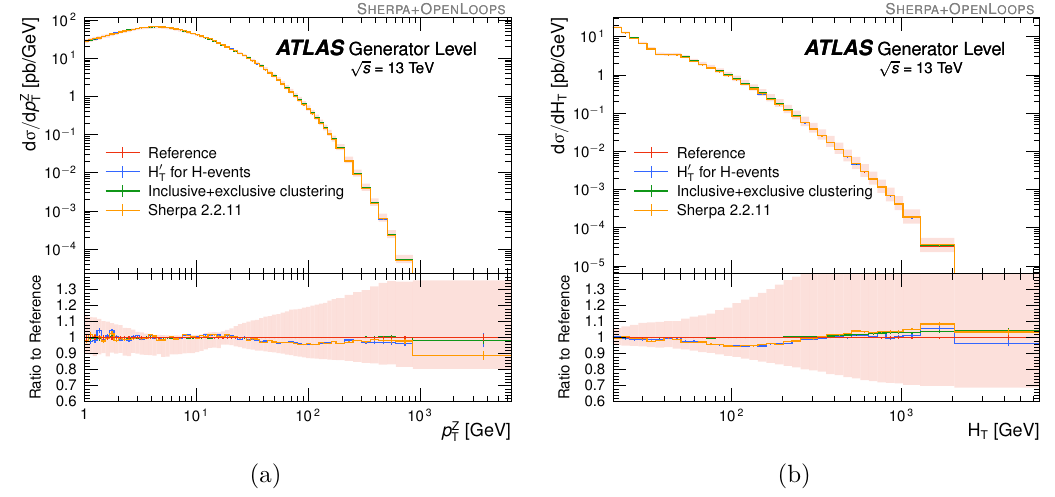
Figure 9 . Differential distributions of (a) the dilepton transverse momentum and (b) scalar sum of the jet momenta for Z → ee generator-level events. The H 0 clustering scheme are added to the reference set-up. The Sherpa 2 . 2 . 11 configuration contains all changes simultaneously. The uncertainty band includes the envelope of the 7-point scale variations of the reference